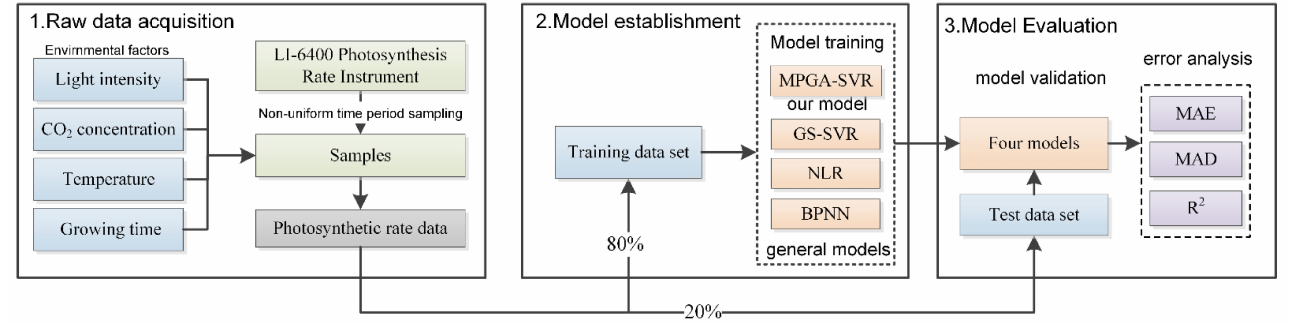
Figure 1. The flow chart of the establishment of the cucumber photosynthetic rate prediction model in whole growth period with time parameters.